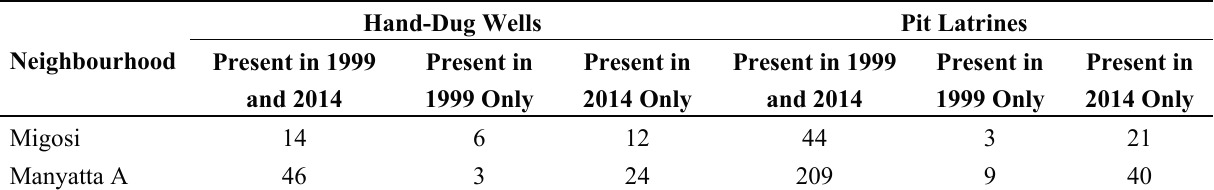
Table 2. Results of a 2014 transect survey of hand-dug wells and pit latrines in the neighbourhoods of Migosi and Manyatta A,